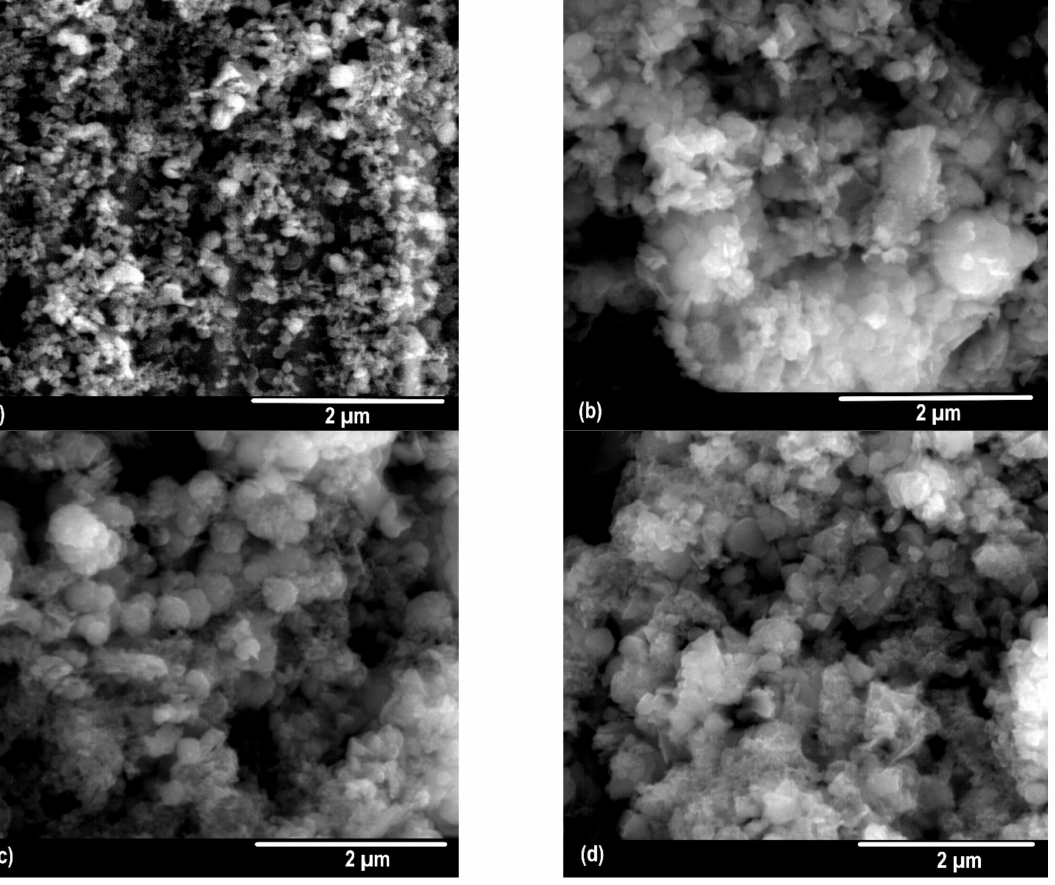
Figure 3. SEM micrographs of CoNiFe-1 ( a ), CoNiFe-2 ( b ), CoNiFe-3 ( c ), and CoNiFe-4 ( d ) at 50,000 × g